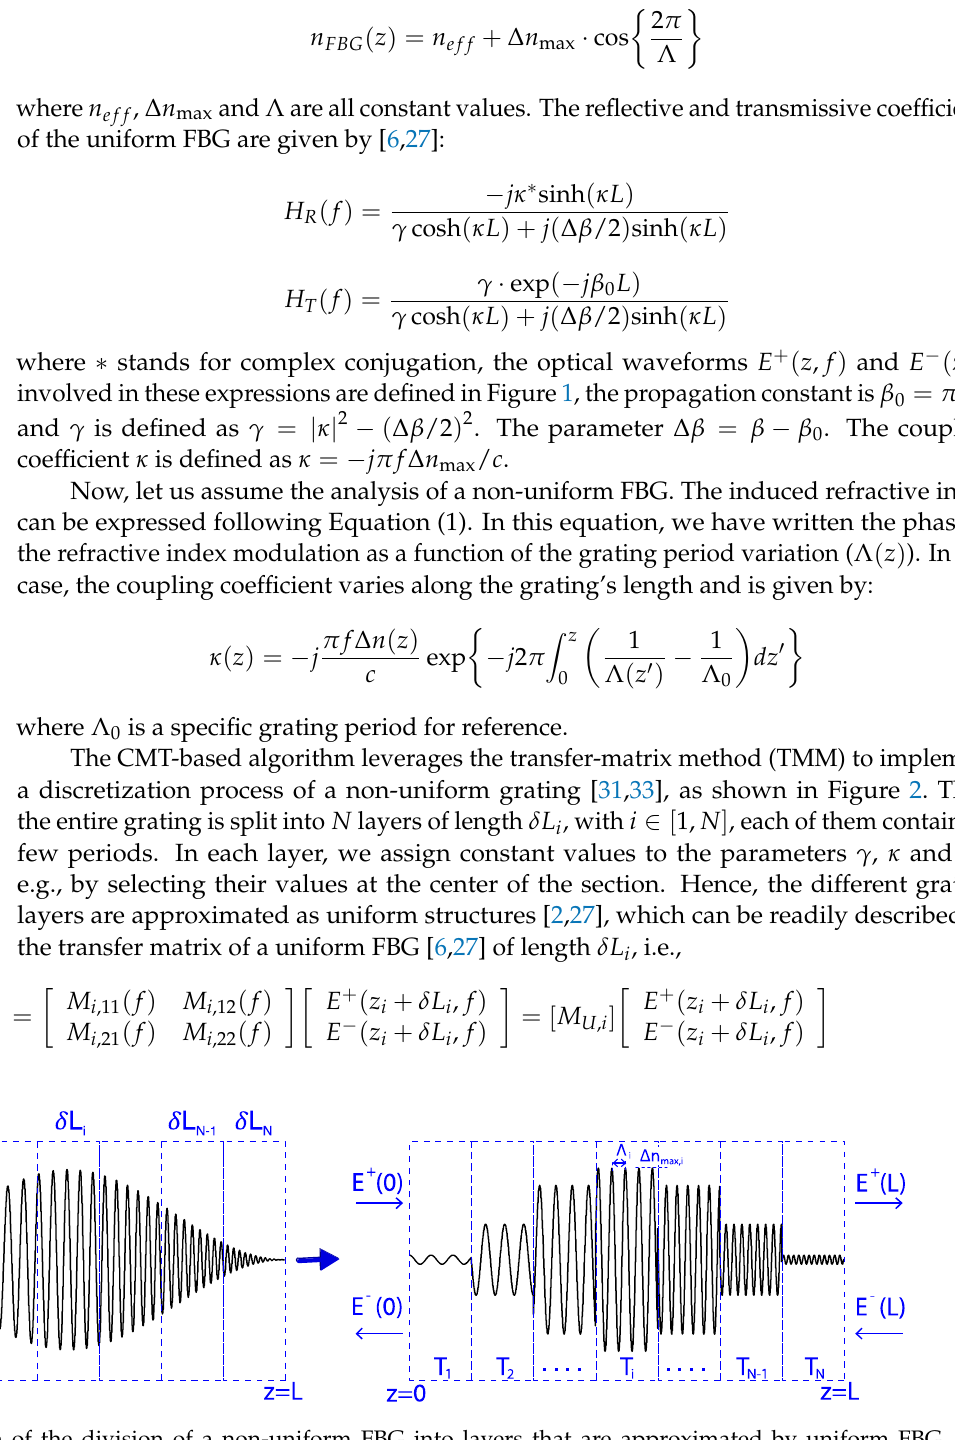
Figure 2. Representation of the division of a non-uniform FBG into layers that are approximated by uniform FBG. The resulting structure can be readily analyzed via CMT and TMM. The dependence of propagating waves with the optical frequency is omitted for the sake of simplicity.